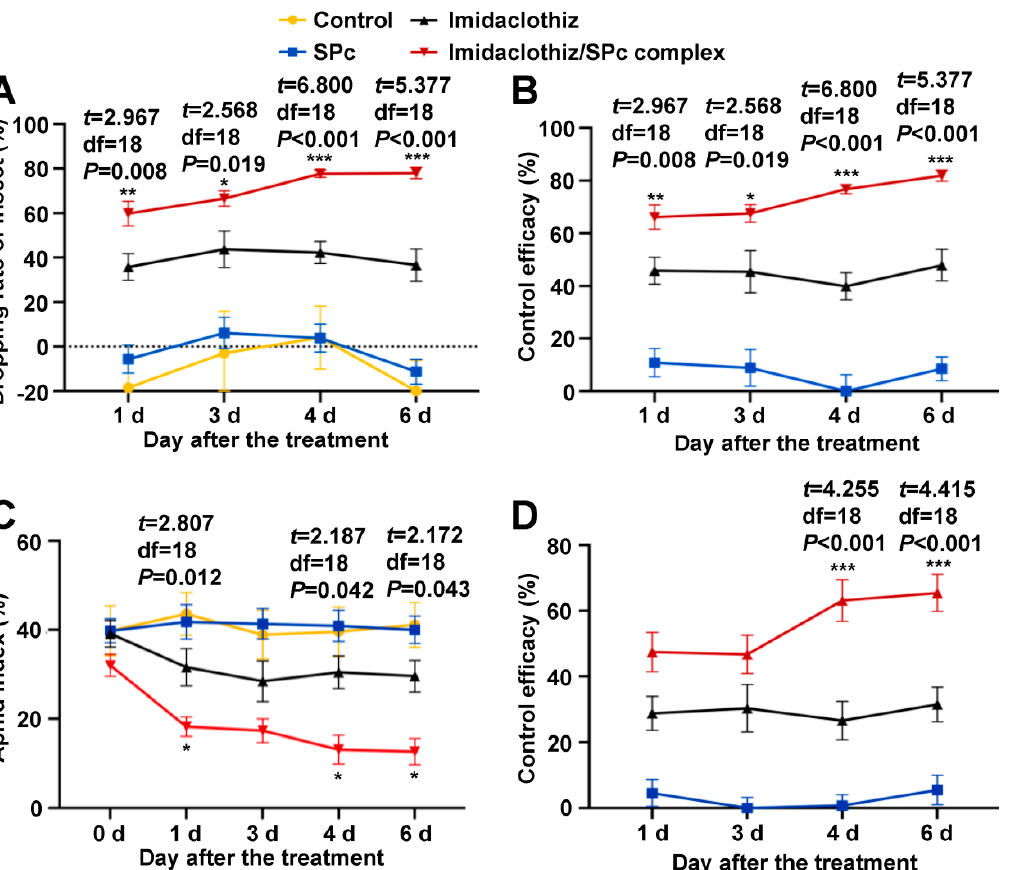
Figure 5. Control efficacy of imidaclothiz/SPc complex toward green peach aphids through spraying method in field. Commercial preparation (cp) of imidaclothiz was mixed with SPc at the mass ratio of 1:1. The 20 and 40 mg/L formulation was sprayed on 0 and 3 d, respectively, with the application amount of 100 mL/m 2 . Sixteen plants from each plot were selected as 16 replicates to record the number of aphids on the top five leaves. Dropping rate of insect ( A ) and control efficacy ( B ) were calculated using method 1, and aphid index ( C ) and control efficacy ( D ) were calculated using method 2. The “*”, “**” and “***” indicate significant differences (independent t test, p < 0.05, p < 0.01 and p < 0.001).